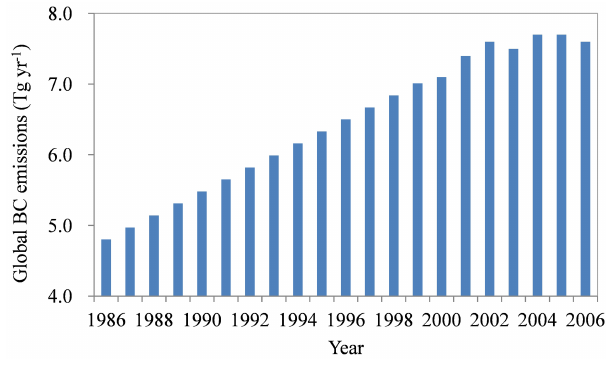
Figure 2. The trend of global BC emission (Tgyr − 1 ) from 1986 to 2006 used in this